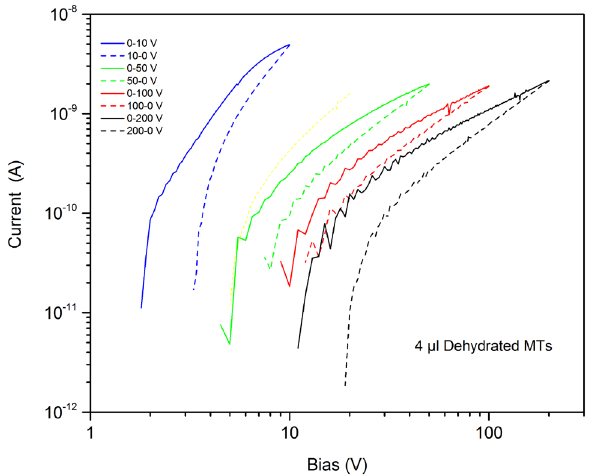
Figure 5. A series of consecutive current versus voltage measurements to progressively higher voltages for a dry 4 µl MT sample measured to progressively higher voltages. Measurements taken at room temperature and for both increasing (solid lines) and decreasing (dashed lines) applied voltages.